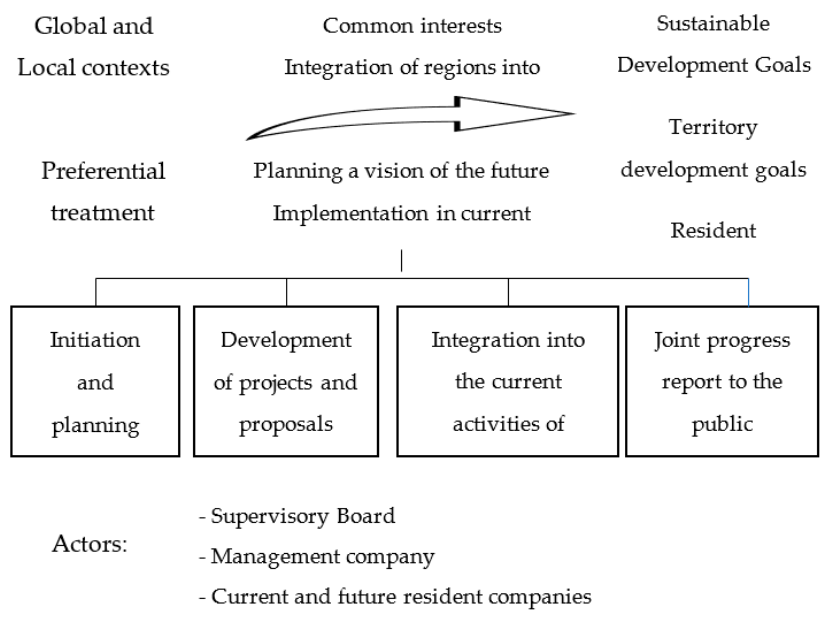
Figure 2. Model of the sustainable development goals (SDGs) implementation in a preferential area of the free port of Vladivostok. Source: developed by the authors. Below are the basic aspects of presented model for the free port of Vladivostok, in more